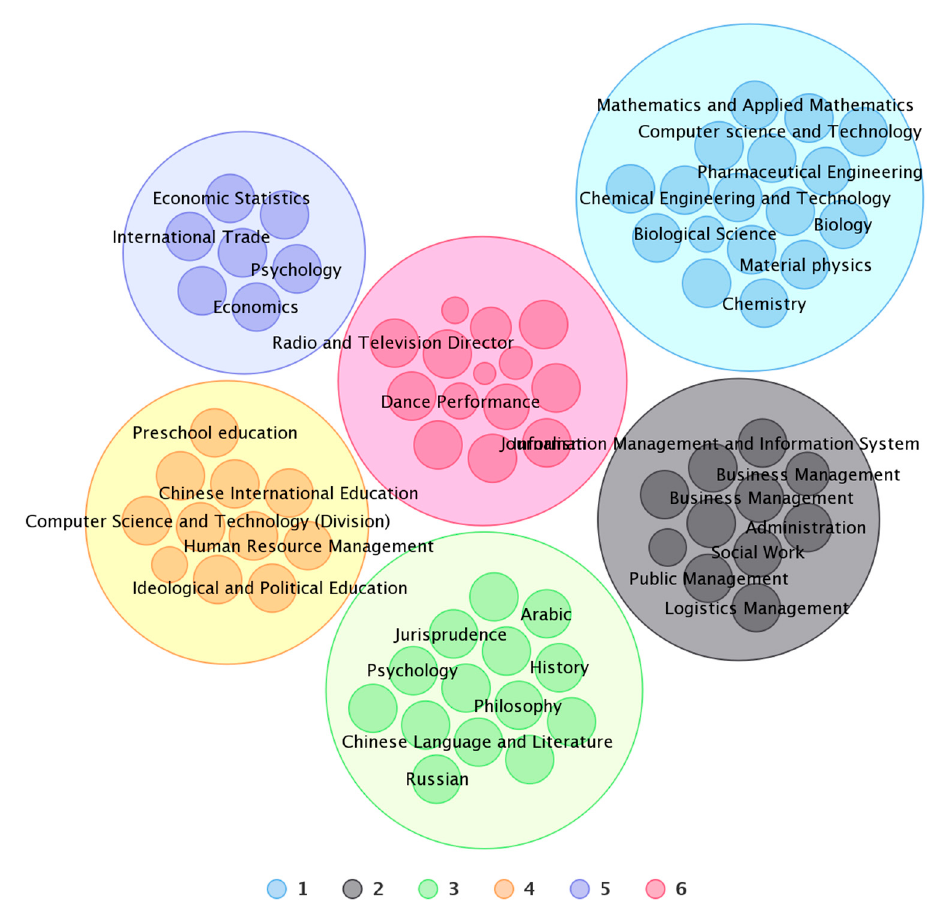
Figure 10. Division of major community structure.